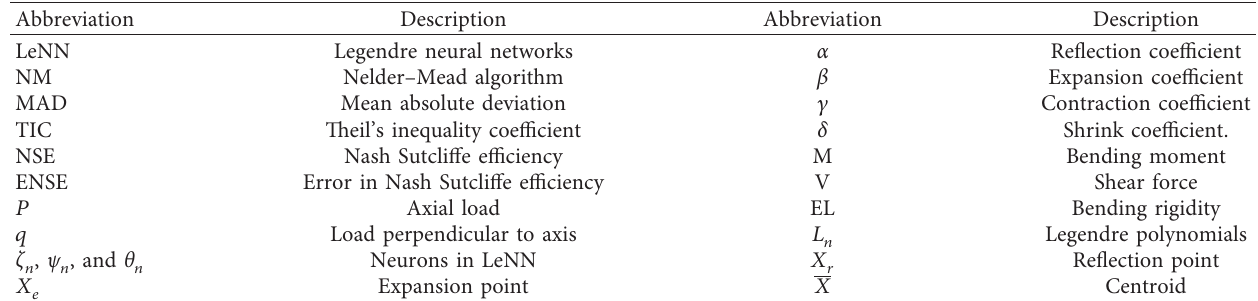
Table 5: Notations and abbreviations used in this